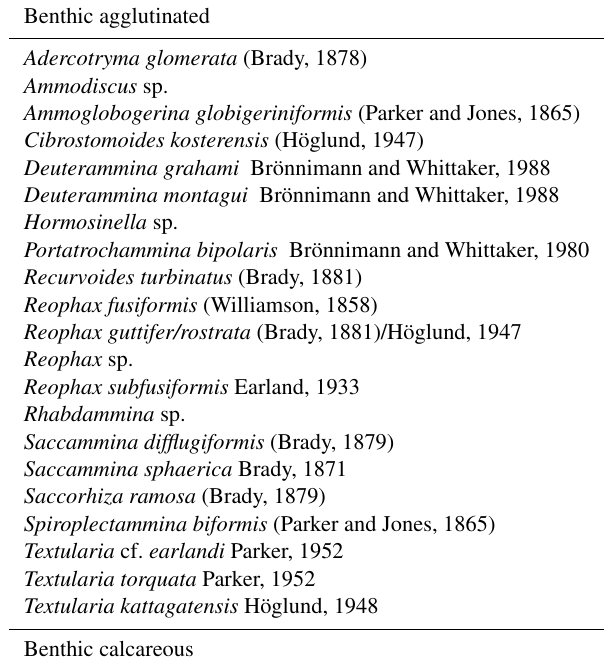
Table A2. Foraminiferal taxa identified in this study (core depth 345–0cm), with their original reference. Benthic calcareous, agglutinated, and planktic species are separated and listed